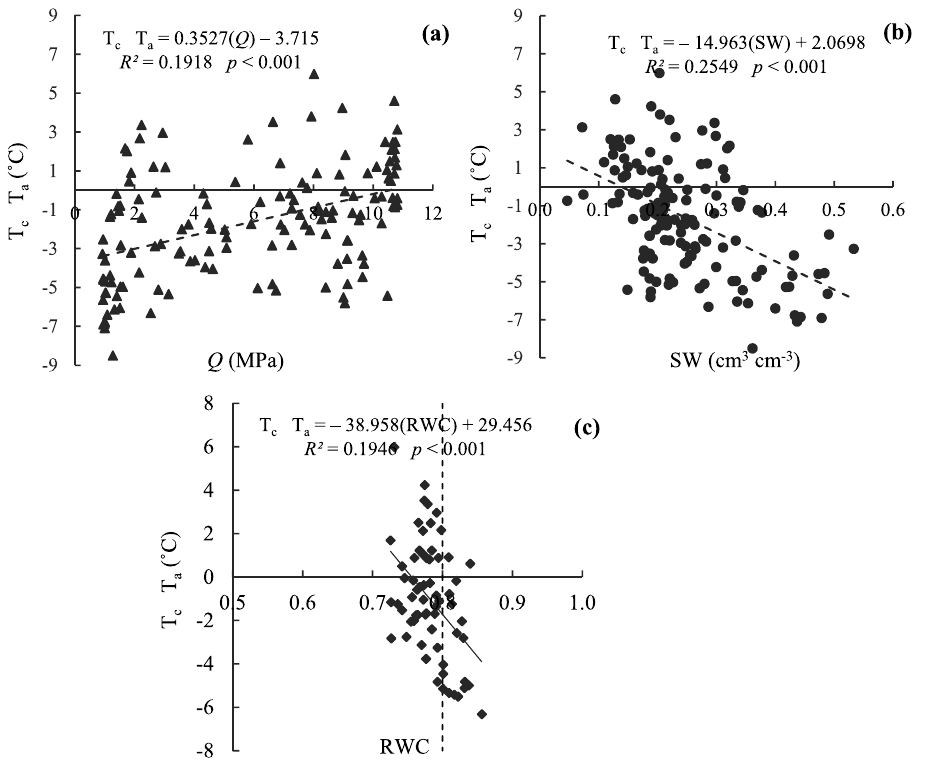
Figure 5. Linear relations between (T c − T a ) and Q ( a ), (T c − T a ) and SW ( b ), and (T c − T a ) and RWC ( c )